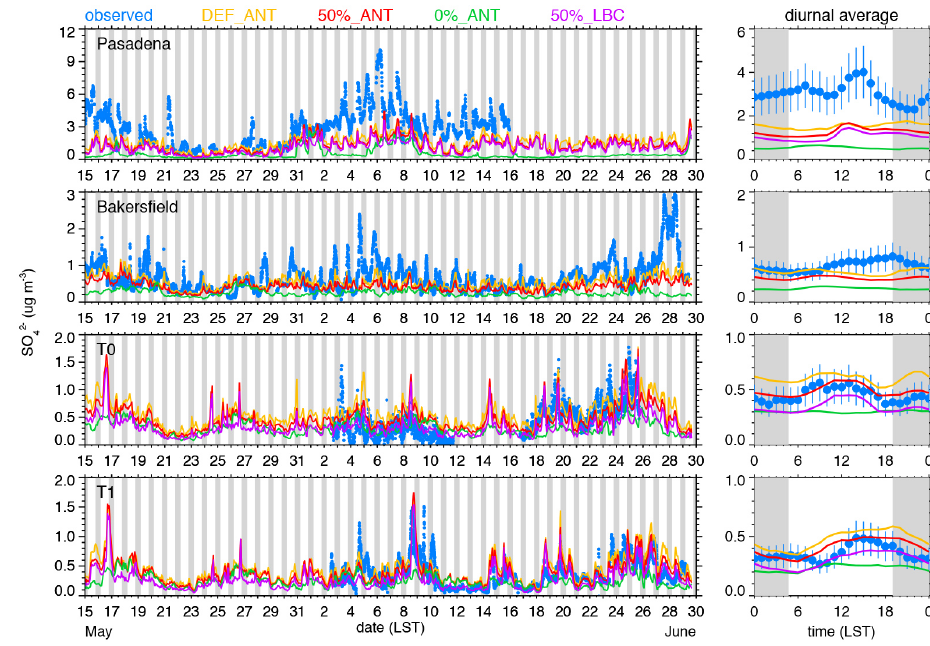
Figure 16. Observed and simulated time series (left panels) and average diurnal variation (right panels) of SO 2 − Simulated SO 2 − is the total of the first four model size bins up to 0.625µm diameter. Gray shading denotes night and vertical lines in right 4 panels denote measurement uncertainty